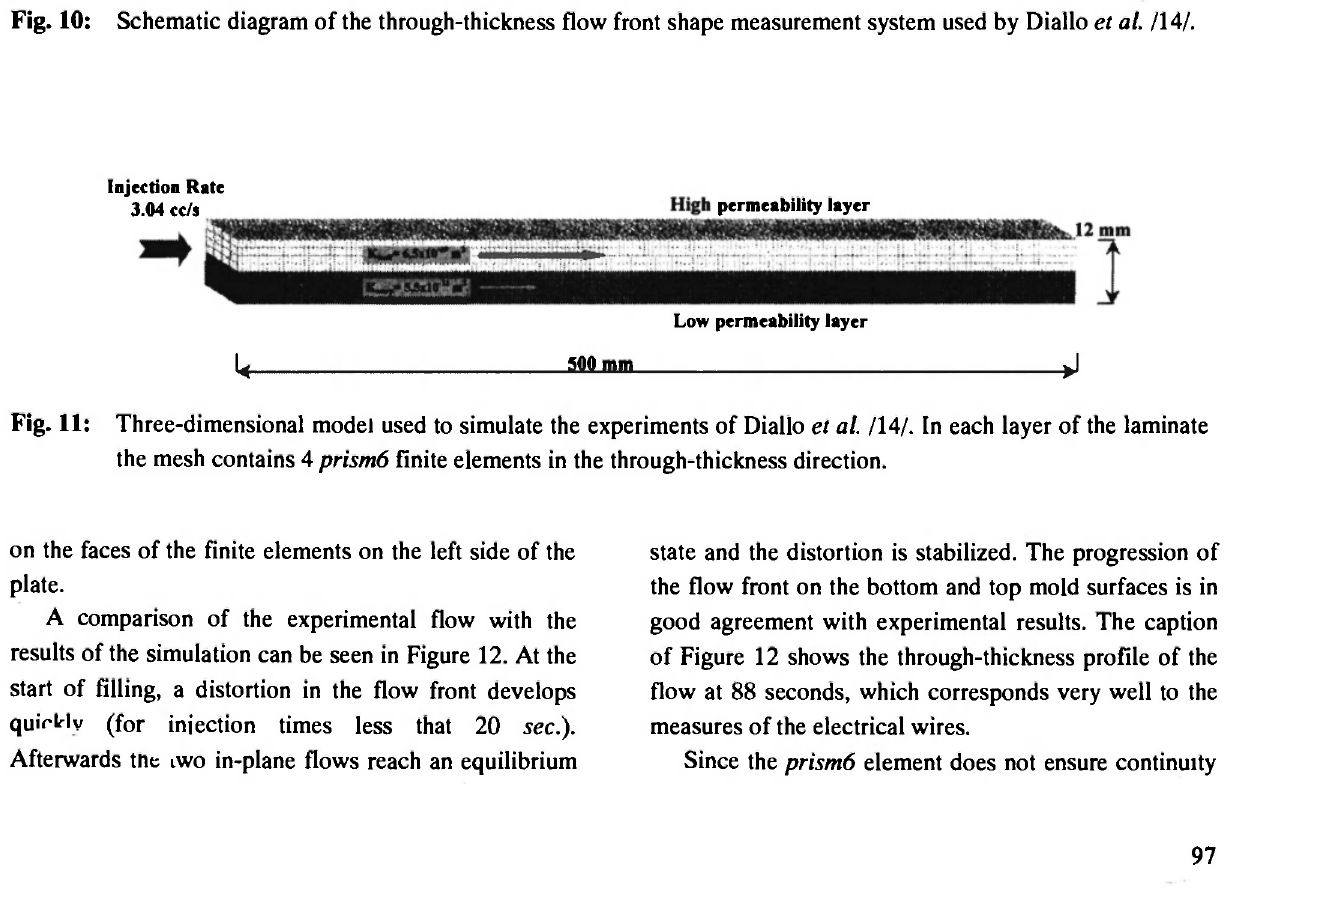
on the faces of the finite elements on the left side of the